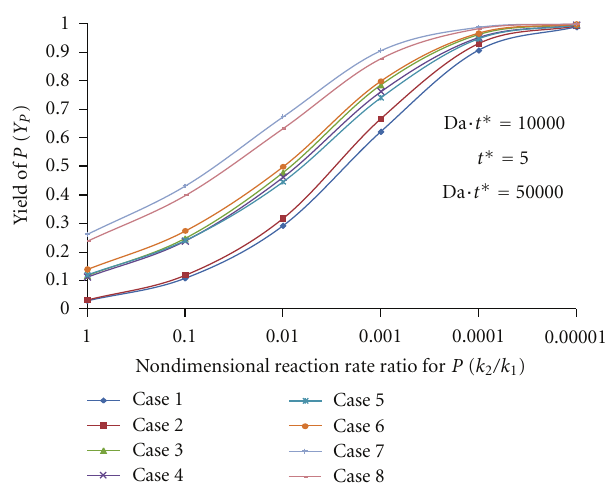
Figure 5: Plot of yield of P versus k 2 / k 1 for Da = 10000 at Da · t ∗ = 50000 for C-C